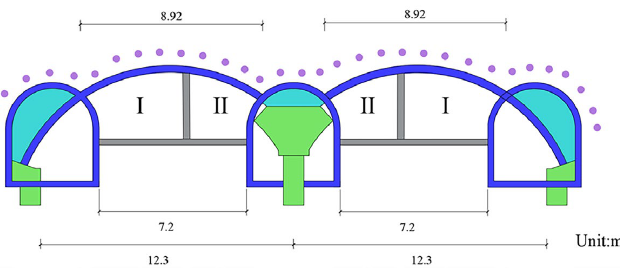
Figure 1. Schematic of the large - span section of Qinghuadongluxikou Station.